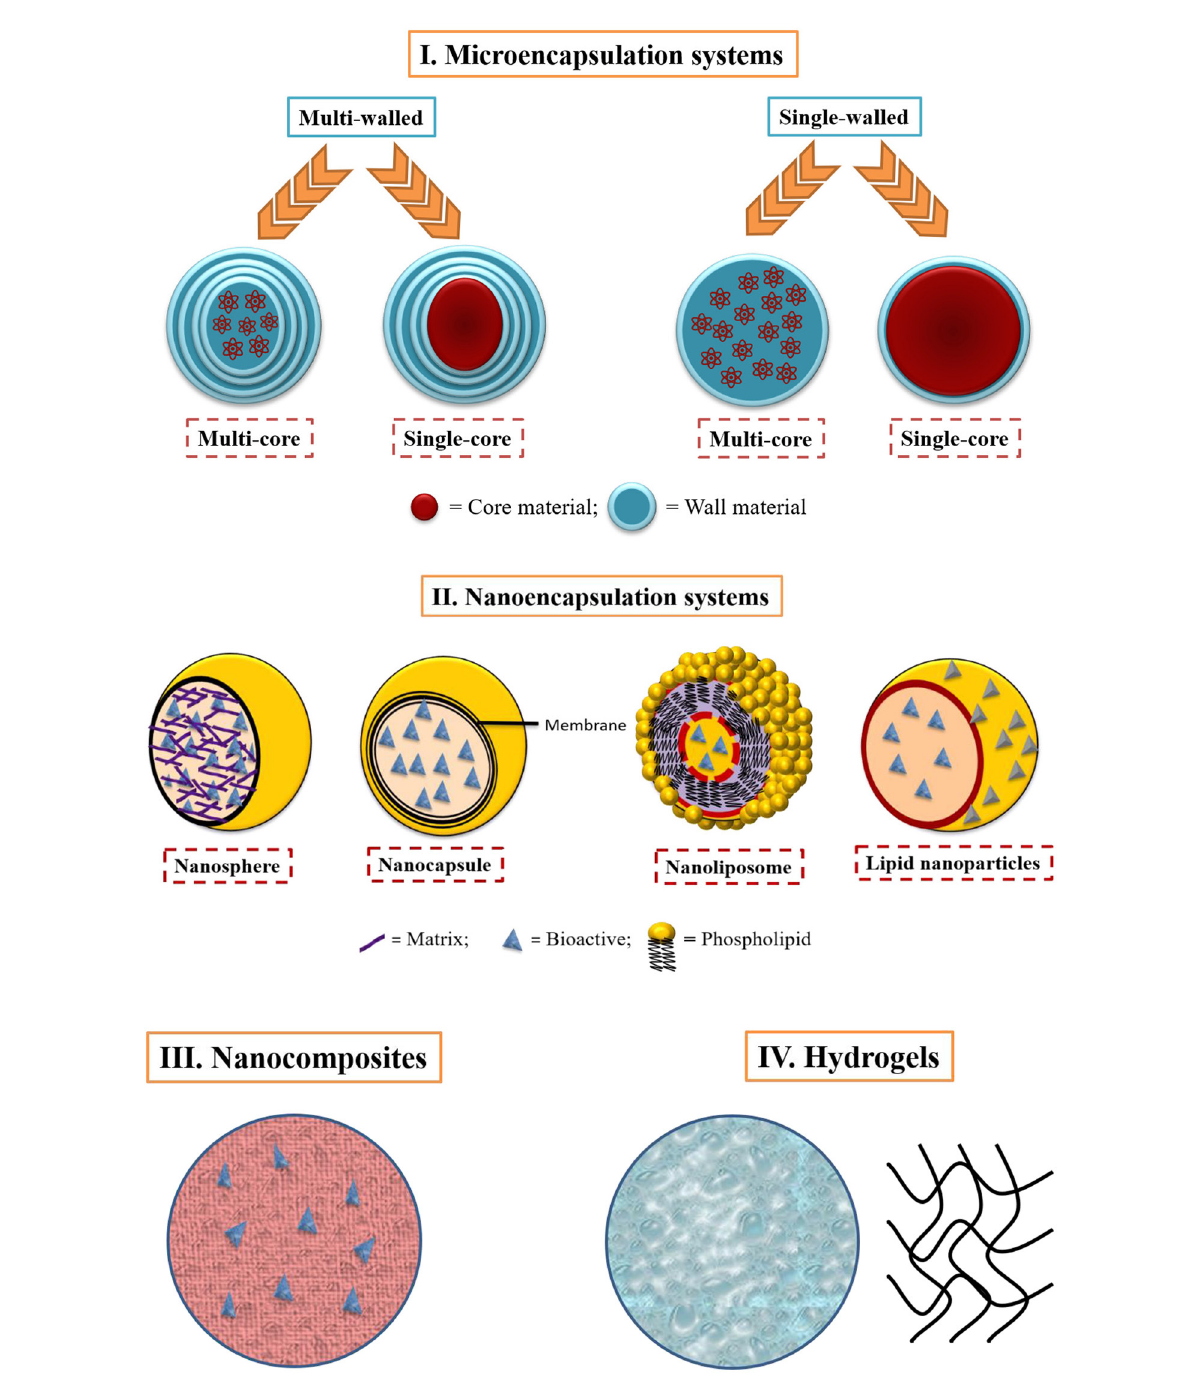
FIGURE2 Milk protein based micro-, nanoparticles, nanocomposites, and hydrogels (38).